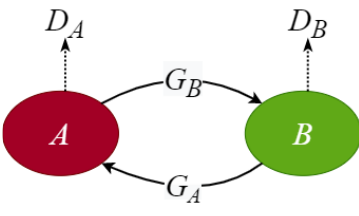
Figure 2. CycleGAN diagram [13].